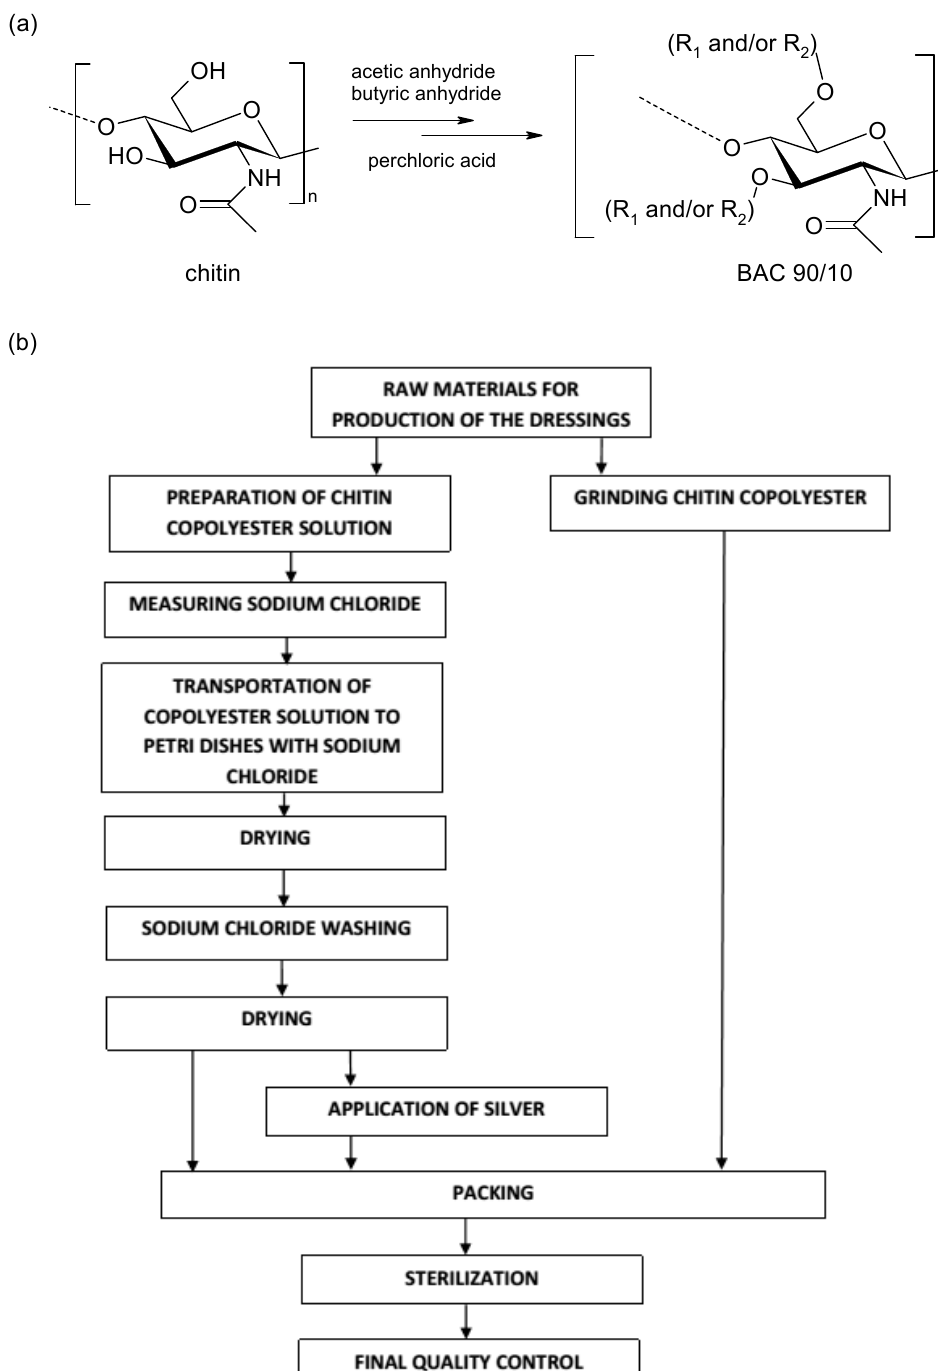
Figure 1. ( a ) Structure of chitin and BAC 90/10; ( b ) block diagram of manufacturing of the porous dressing materials, Medisorb series R Membrane, Medisorb R Ag, derived from BAC 90/10.